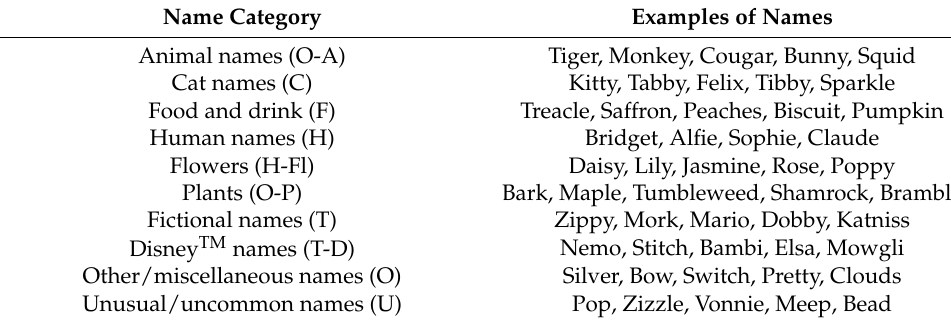
Figure 2. The algorithm used for retrospectively categorising cat names. Ten categories were created: animal names (O-A), cat names (C), food/drink (F), human names (H), flowers (H-Fl), plants (O-P), fictional character names (T), Disney TM names (T-D), other/miscellaneous names (O) and unusual/uncommon names (U). Indicative examples of cat names and the categories to which they were allocated are given in Table 1. Table 1. Examples of different cat names and how they were